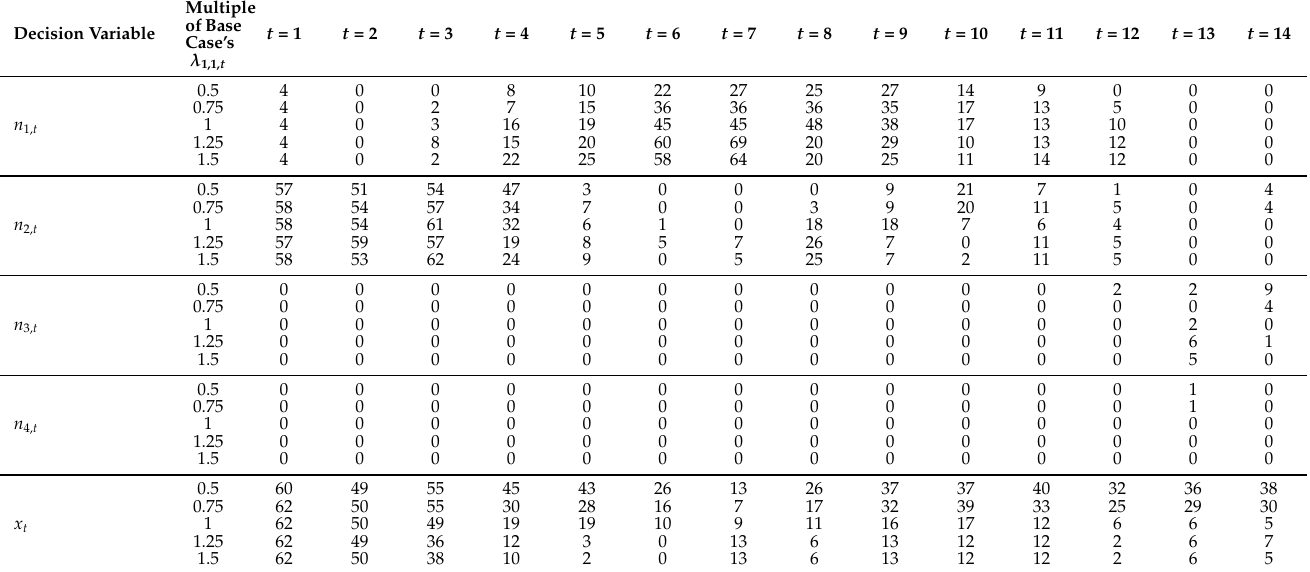
Table 7. Comparison of optimal decision schemes in case